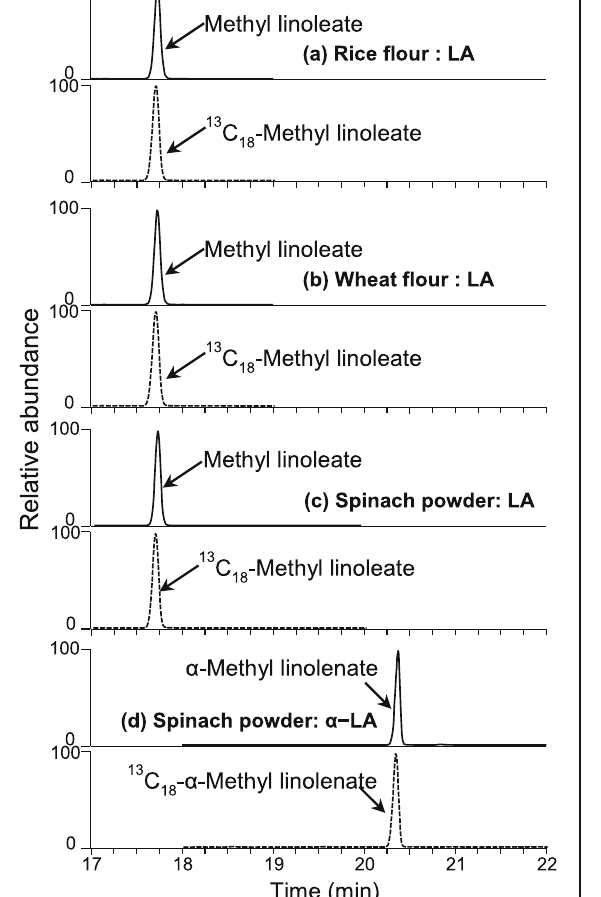
Table 1 Results of ID-GC/MS measurements for homogenized samples of rice and wheat flours at three different time